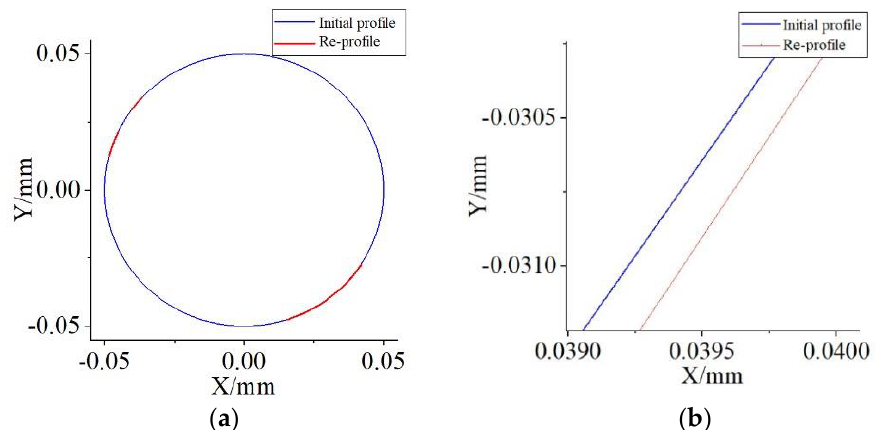
Figure 15. Rearrangement of shaft sleeve after wear: ( a ) Rearrangement; ( b ) Partial magnification.